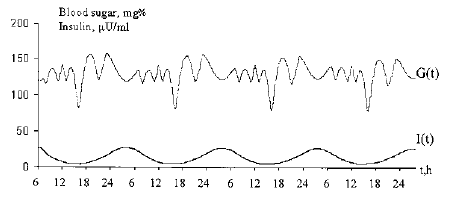
Figure(cid:6)(cid:1)InthemorninginjectionLenteinsulinandRegularinsulininjected